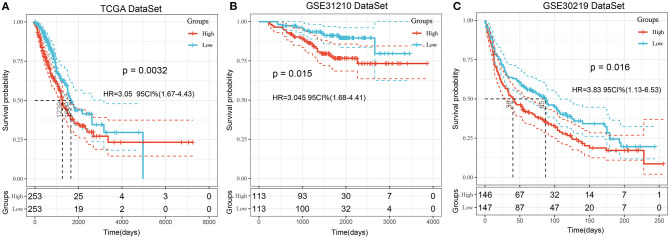
Prognostic signature construction and validation. (A) Significant prognostic differences between groups in the TCGA training cohort. (B) Significant prognostic differences between groups in the testing cohort (GSE31210). (C) Significant prognostic differences between groups in the external validation cohort of GSE30219. Abscissa represents survival time (days), ordinate represents overall survival, the p-value represents the significance of gene combinations with different expression for the prognosis classification of LUAD. Log rank p-test was used.